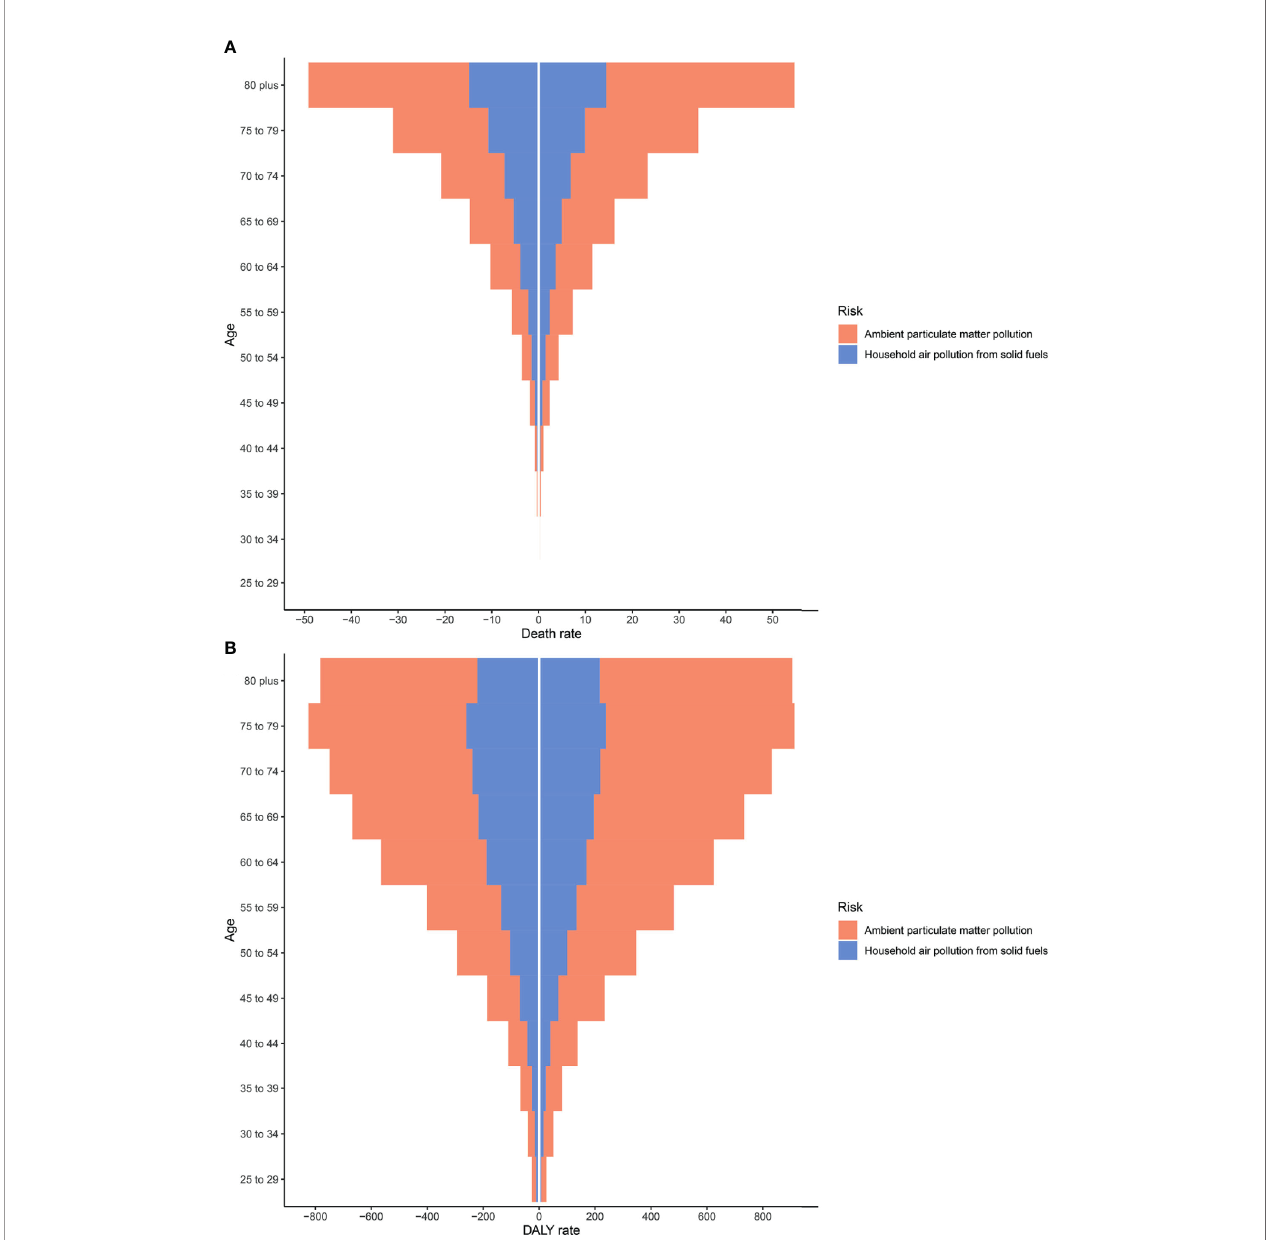
FIGURE 2 | Type 2 diabetes mellitus burden among different genders and ages in 2019. (A) Death rates. (B) DALY rates. DALY, disability-adjusted life